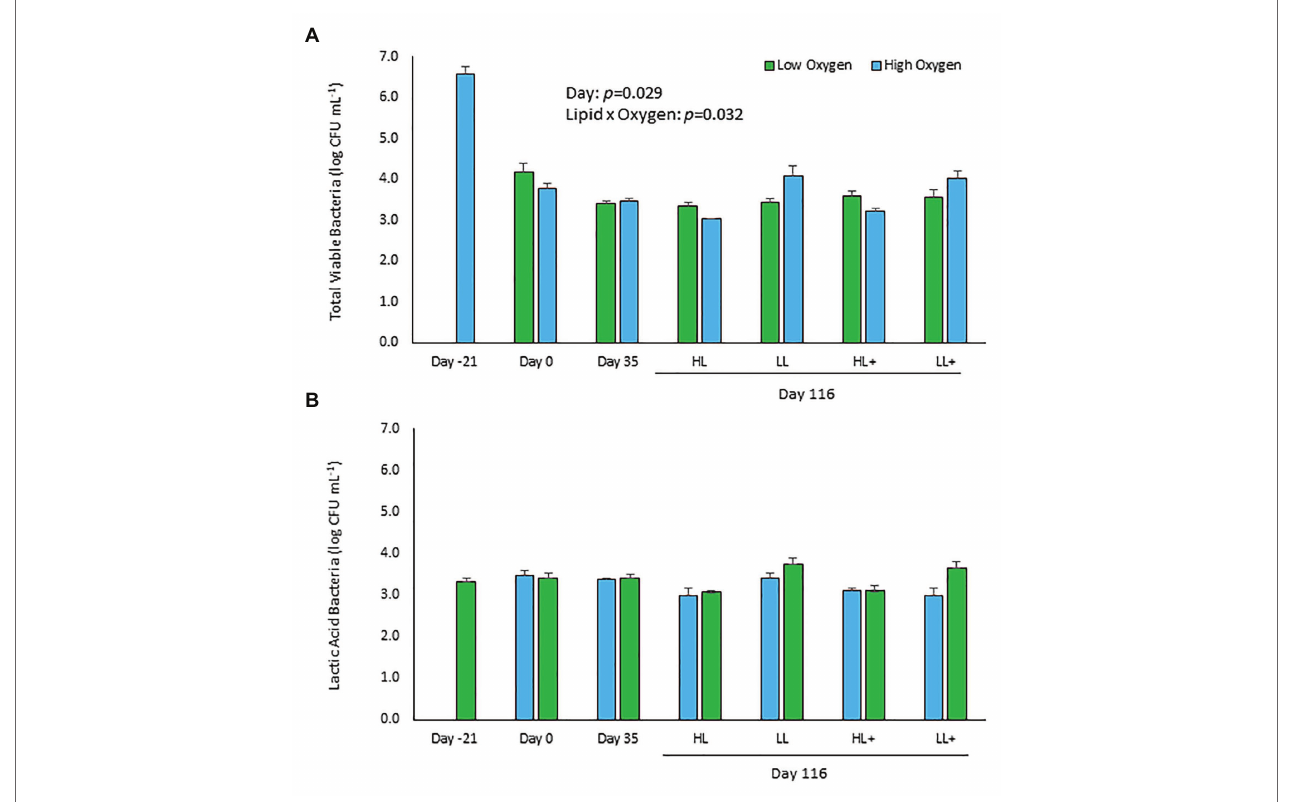
FIGURE 1 | Viable plate counts of (A) total and (B) lactic acid bacteria (±SE) cultured on typtone soya agar (TSA) and man-rogosa-sharpe agar (MRS) plates of feces collected from the distal intestine of Atlantic salmon fed HL or LL diets with or without additional n-3 PUFA (+) and reared at low or high oxygen. Fish were sampled at -21 ( N = 9), 0 ( N = 23), 35 ( N = 48), and 116 days ( N = 55). Some samples excluded due to fungal overgrowth.